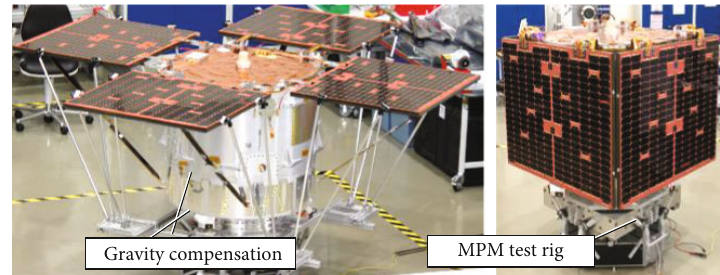
Figure 15: FM MPM